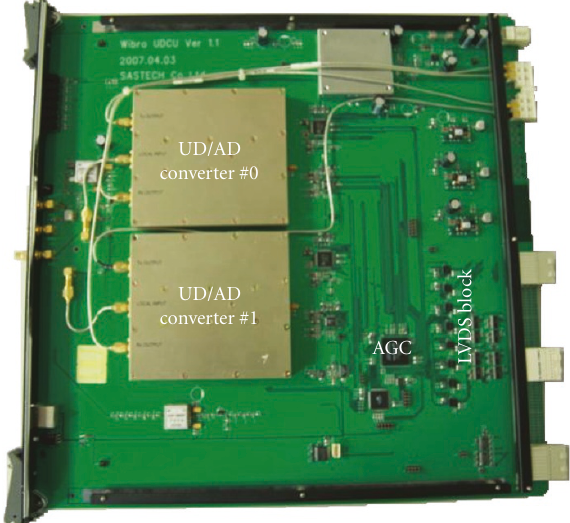
Figure 8: Photograph of the UDCU for the m-WiMAX SA BS.